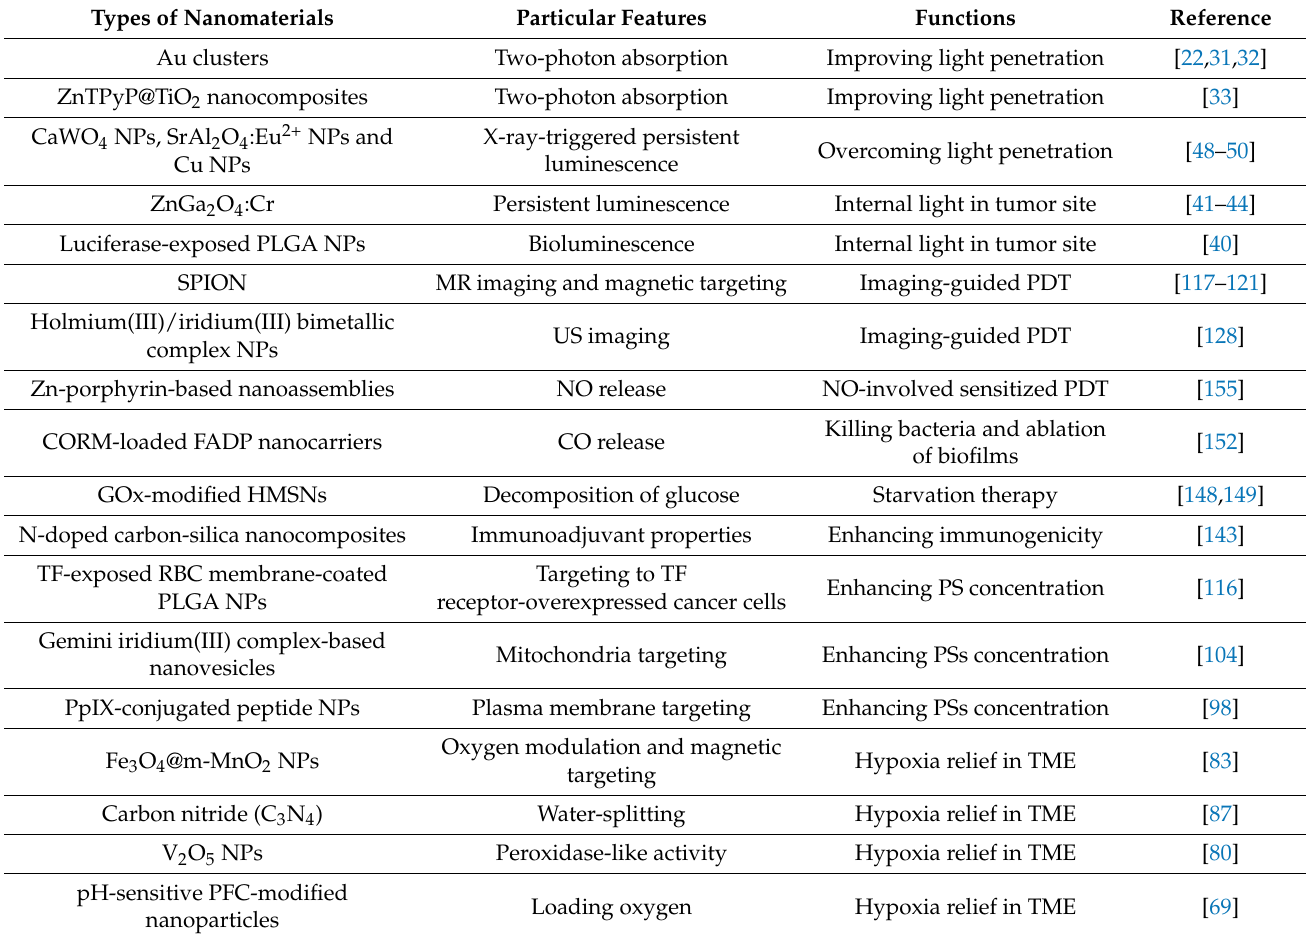
Table 1. Summary of recent strategies using nanocarriers to resolve the limitations of practical photodynamic therapy (PDT)